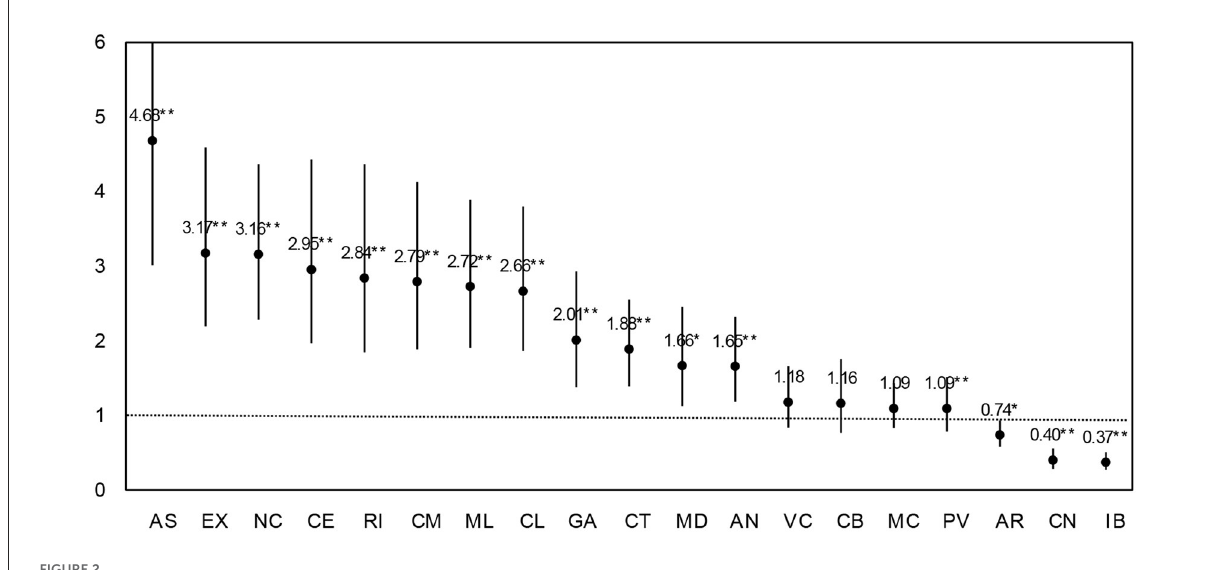
FIGURE2 Effect of school reopening in each ACs. Estimates are incidence-rate ratios from Poisson regressions corrected for over dispersion. 95% CI. ** p < 0.01, * p < 0.05.